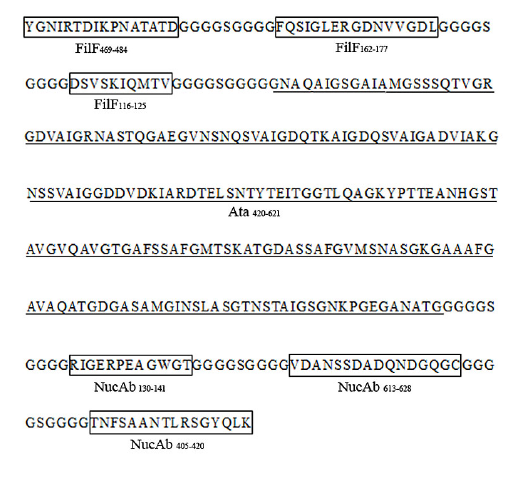
Figure 1: Amino acid sequence of the designed multi-epitope assembly peptide (MEP). The T- and B-cell epitopes of outer membrane protein FilF and NucAb from A. baumannii were pre- dicted and identified by using bioinformatics software and immuno- logical tests. Peptides with predicted high adhesin probability from A. baumannii Ata protein was used as the backbone. The GGGGSGGGG peptide was used as the flexible linker. FilF 469–484 ,